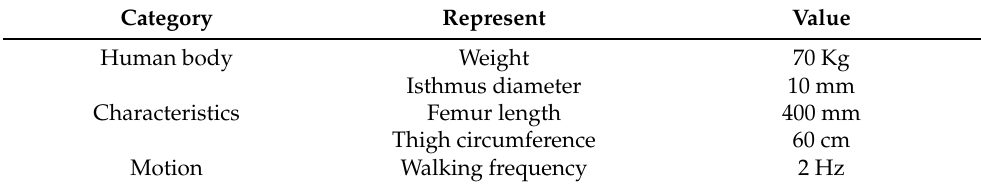
Table 1. Lower extremity of the subject.